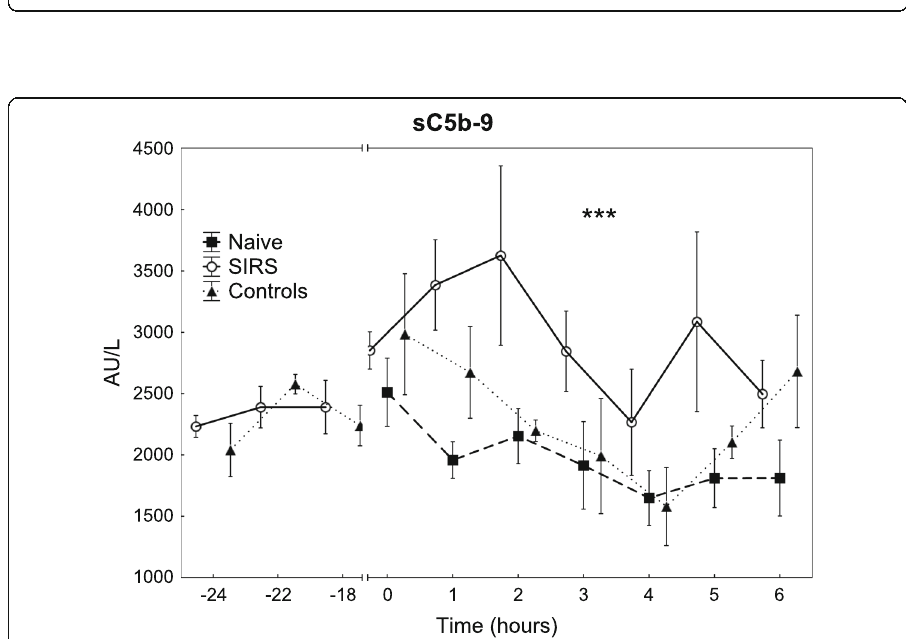
Fig. 4 The levels of tumour necrosis factor alpha (TNF- α ) ( a ), interleukin 6 (IL-6) ( b ), interleukin 10 (IL-10) ( c ) and interleukin 10/TNF- α ratio ( d ) during the experiment. All animals were subjected to an E. coli infusion for 3 h starting at 0 h. The SIRS group received endotoxin and the control group saline for 24 h before the bacterial infusion. Values are expressed as mean ± SEM (standard error of the mean). ** p < 0.01, *** p < 0.001. Difference between the SIRS vs. naive group. ‡‡‡ p < 0.001. Difference between the control vs. naive group. All assessed with ANOVA III for repeated measurements